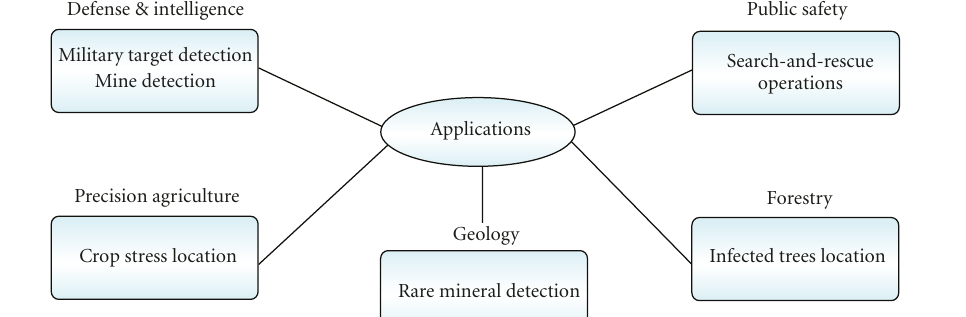
Figure 2: Applications of target and anomaly